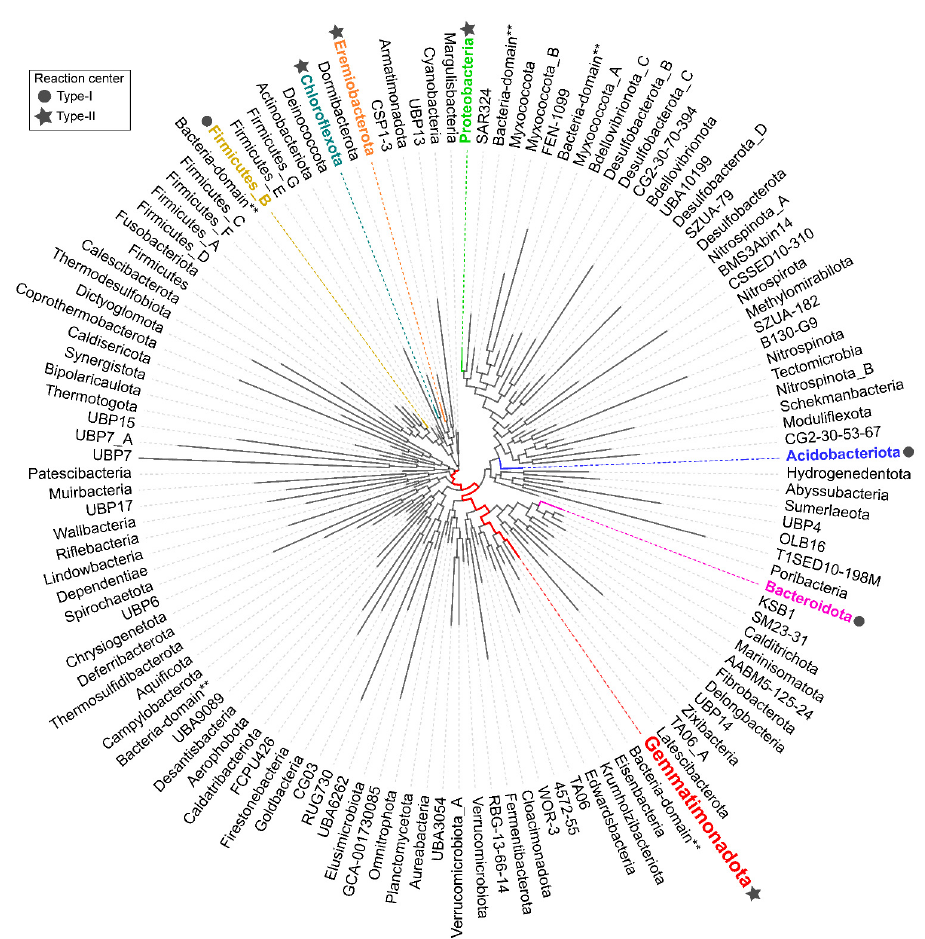
Figure 1. Phylogenomic tree of all bacterial phyla present in the Genome Taxonomy Database (GTDB) (Release RS95) [13,14] visualized using AnnoTree (version 1.2) [12], showing the position of Gemmatimonadota (marked in red). Additionally, along Gemmatimonadota, six other phyla that contain members capable of anoxygenic photosynthesis are marked in different colors, and the type of reaction center is indicated with a circle or a star (left legend). The double asterisk (**) means there is no corresponding taxonomy in GTDB for the genome so higher taxonomy level is used. The tree was edited in Inkscape (version 1.0).